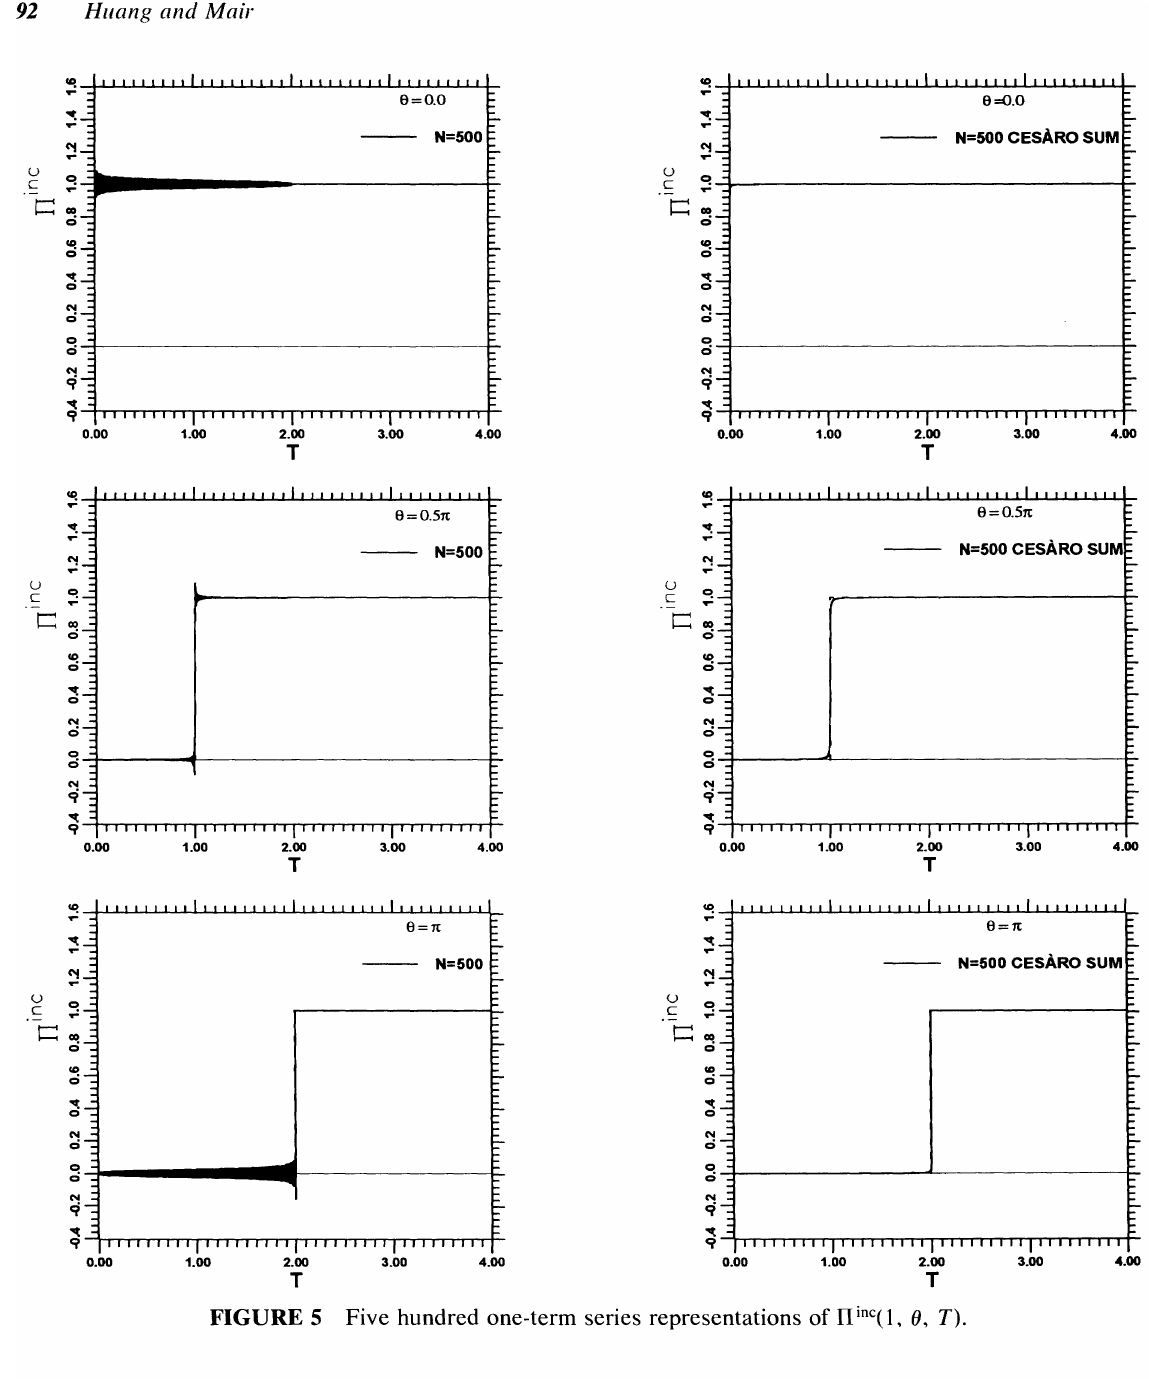
FIGURE 5 Five hundred one-term series representations of IIinc(l, (J,